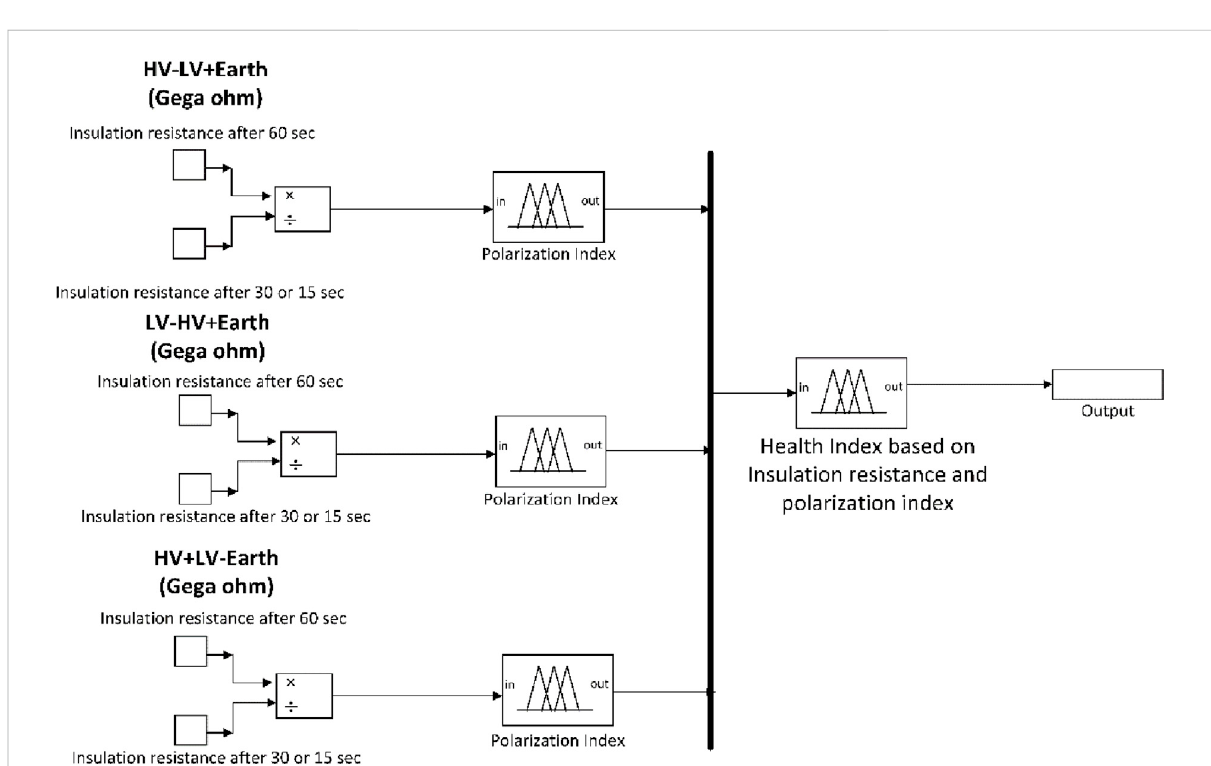
FIGURE 11 Fuzzy sublogic based on insulation resistance and polarization